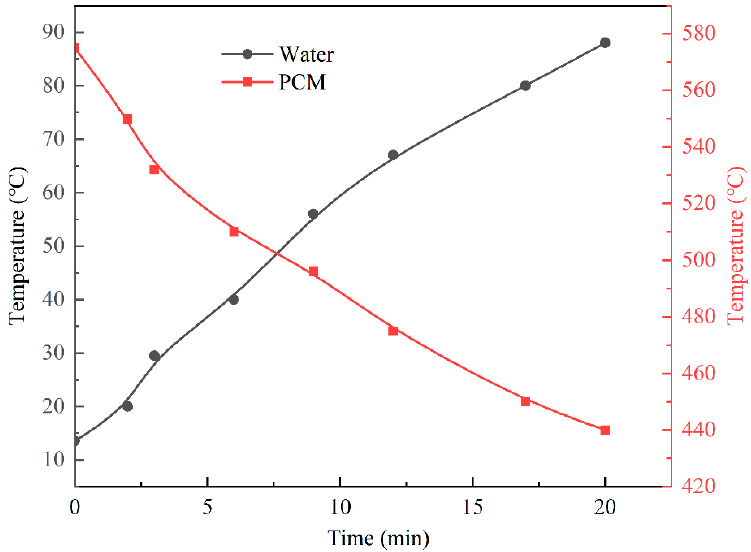
Figure 13. Exothermic process for the PCM when the water temperature changed.